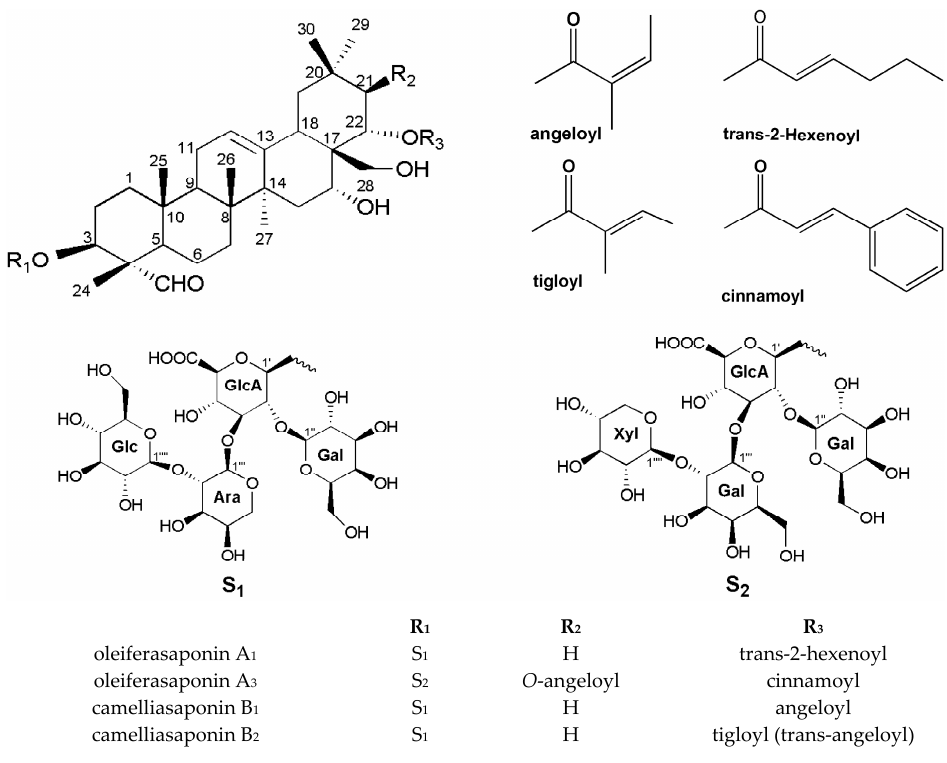
Figure 1. Structure of compounds.